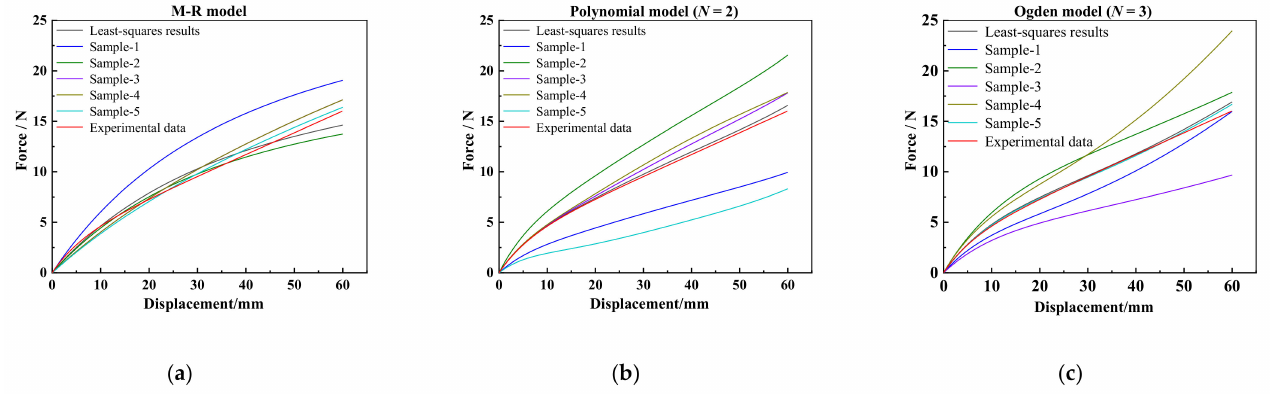
Figure 8. Numerical results of force-displacement curves and experimental curve: ( a ) M–R model results for learning samples of GRNN; ( b ) Polynomial model ( N = 2) results for learning samples of GRNN; ( c ) Ogden model ( N = 3) results for learning samples of